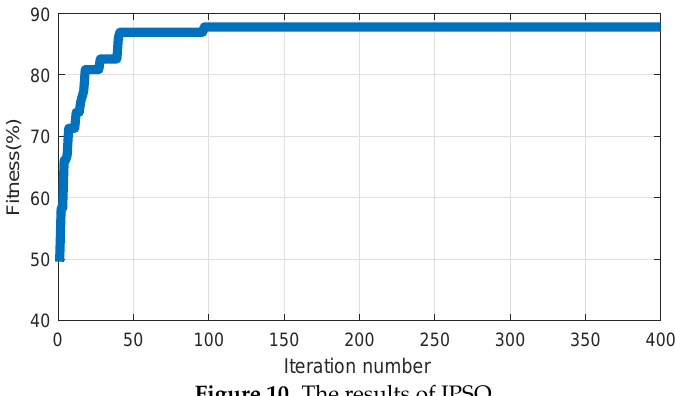
Figure 10. The results of IPSO.